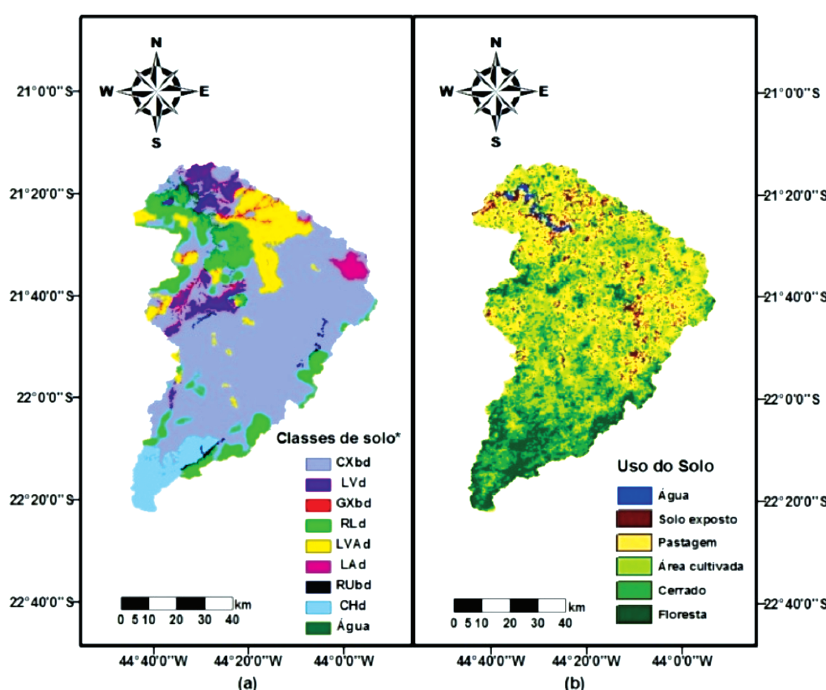
Figura 1. Mapas de solos (a) e uso do solo (b) da Bacia Hidrográfica do Alto Rio Grande, MG. Adaptados de Araújo (2006) e Beskow et al.